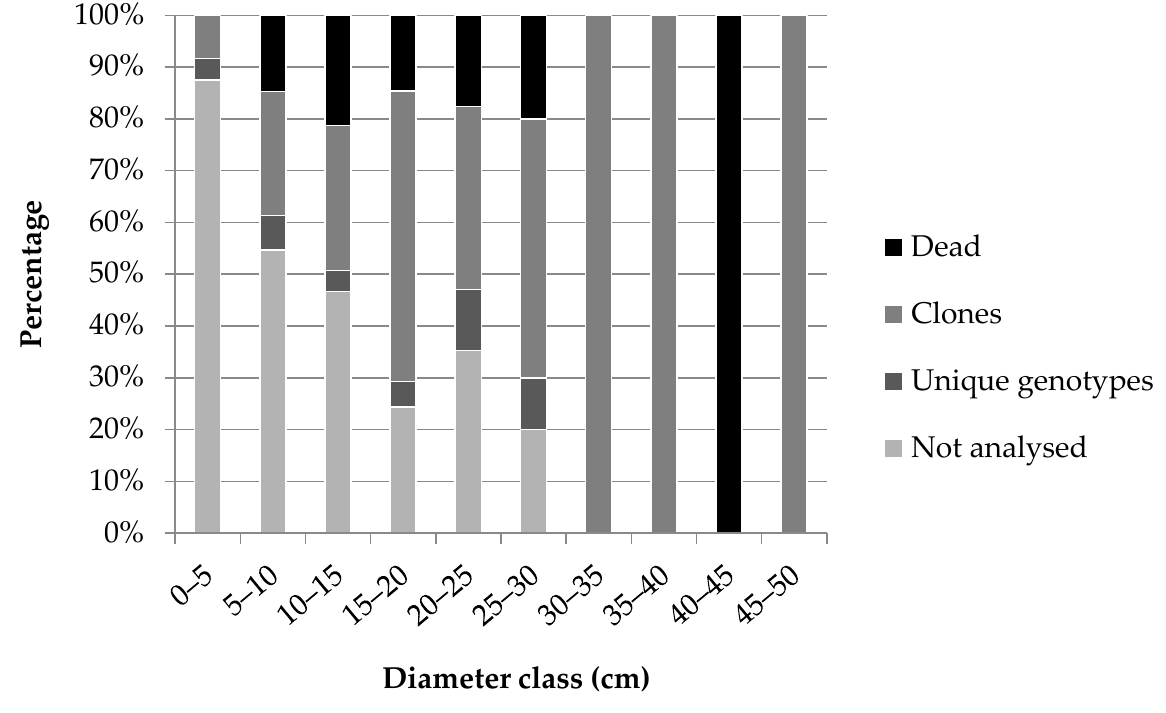
Figure 5. Percentages of dead, clones, unique genotypes and not analyzed stems classified by diameter class (CD) in cm in plots A and B.